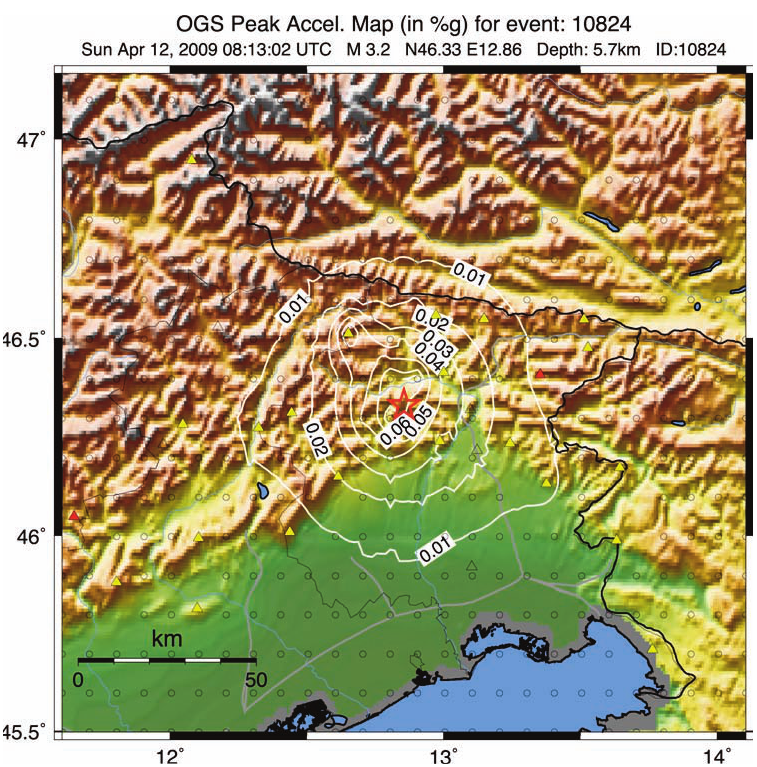
Figure 9. Shake map of the horizontal peak ground acceleration estimated for an ML 3.2 earthquake that occurred in